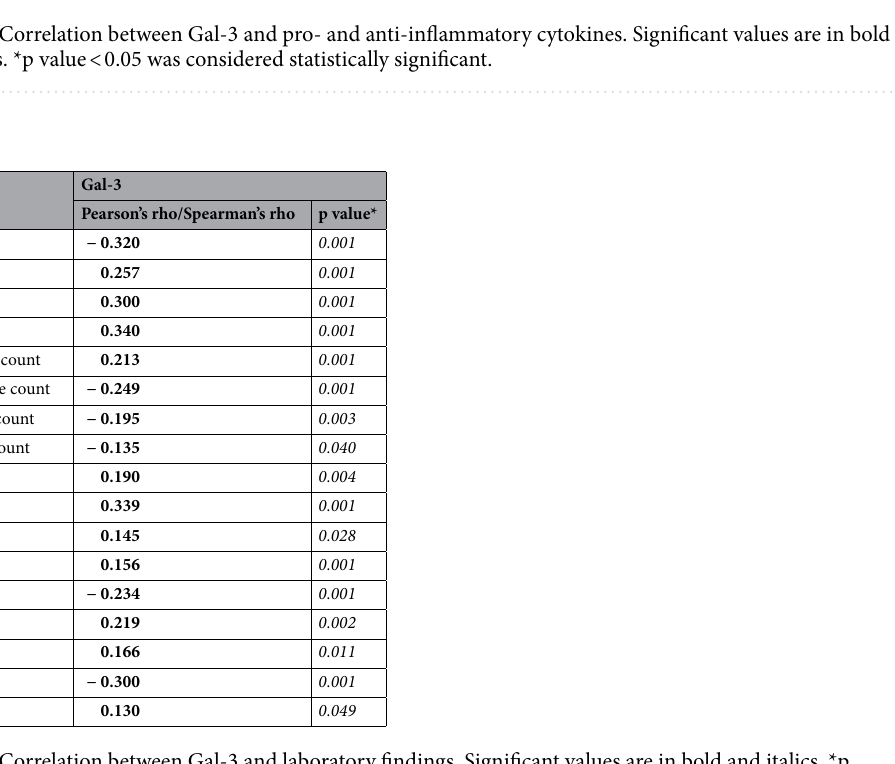
Table 4. Correlation between Gal-3 and laboratory findings. Significant values are in bold and italics. *p value < 0.05 was considered statistically